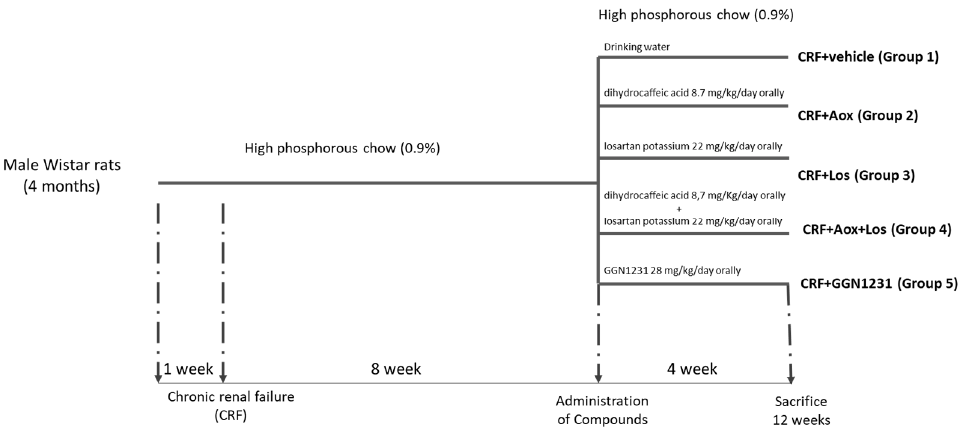
Figure 1. Experimental design of the rat model of chronic renal failure fed a high phosphorus diet. CRF (chronic renal failure); Aox (antioxidant); Los (losartan); Aox+Los (antioxidant plus losartan); GGN1231 (antioxidant plus losartan hybrid).